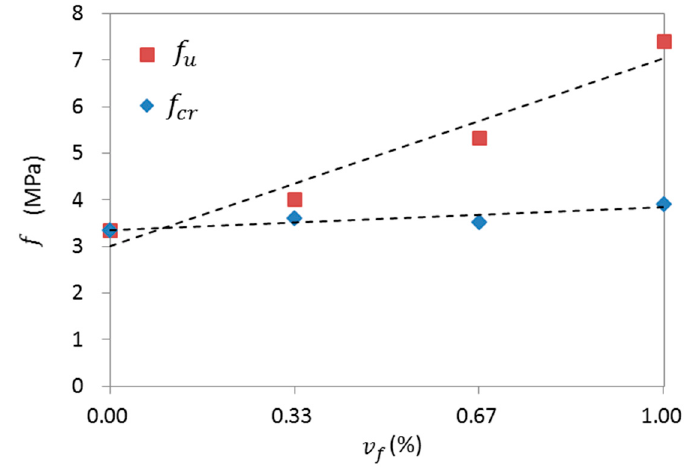
Figure 3. Cracking and ultimate strengths with increasing fiber volume percentages from zero to 1.00%.